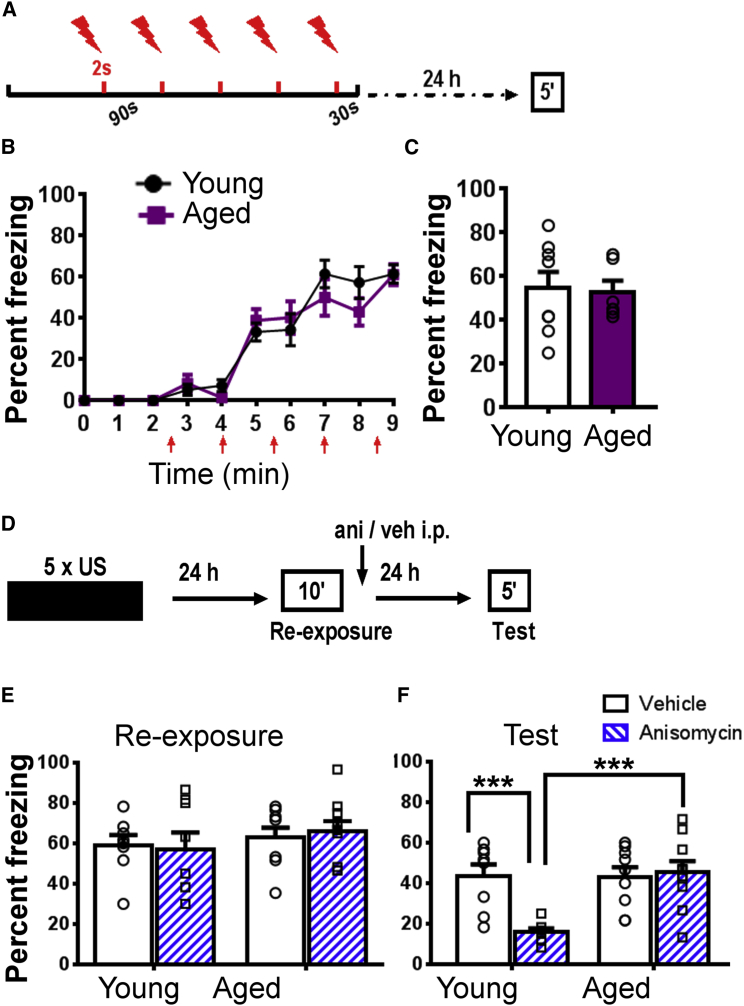
Aged Mice Can Form Contextual Fear Memory as Young Mice, but Reconsolidation of Their Memory Is Impaired(A) The CFC protocol is schematically shown. After 148 s, a 2-s foot shock (0.70 mA) was given and followed by four more foot shocks in 90-s intervals. Thirty seconds after the last foot shock the mouse was returned to its home cage and tested for contextual memory 24 h after conditioning.(B) Young (n = 8) and aged mice (n = 6) did not differ in CFC, as shown by the relative time spent freezing (effect of aging, F(1,125) = 0.22, p = 0.65; effect of training, F(8,125) = 60.6, p < 0.001; interaction age x training, F(8,125) = 1.22, p = 0.30).(C) Aged mice had the same level of contextual freezing 24 h after CFC as young mice (unpaired t test, p = 0.93).(D) Experimental design for testing whether contextual fear memory is destabilized by retrieval, the initial step of reconsolidation which is thought to be required for memory updating [21]. Immediately after re-exposure to the context the protein synthesis blocker anisomycin (Ani; 225 mg/kg) or vehicle (veh; saline) was injected intraperitoneally (i.p.) and after 24 h contextual fear memory was re-tested (test).(E) Both young (nYveh = 8, nYAni = 8) and aged mice (nAveh = 9, nAAni = 10) had similar contextual fear memory during re-exposure. Note that the vehicle or anisomycin treatment occurred after re-exposure.(F) Anisomycin treatment (open bars versus filled bars; circles and rectangles show individual data plots for vehicle and anisomycin treatment, respectively) did not destabilize contextual fear memory in aged mice in contrast to young mice (effect of age, F(1,31) = 8.53, p < 0.01; effect of treatment, F(1,31) = 6.49, p < 0.01; interaction treatment x age, F(1,31) = 9.22, p < 0.01; Tukey’s post hoc tests: Yveh versus YAni, p < 0.001; Aveh versus AAni, p = 0.72; Yveh versus Aveh, p = 0.94; YAni versus AAni, p < 0.001).Mean ± SEM, ∗∗∗p < 0.001. Individual data plots representing each animal within the group overlay the bar graphs.